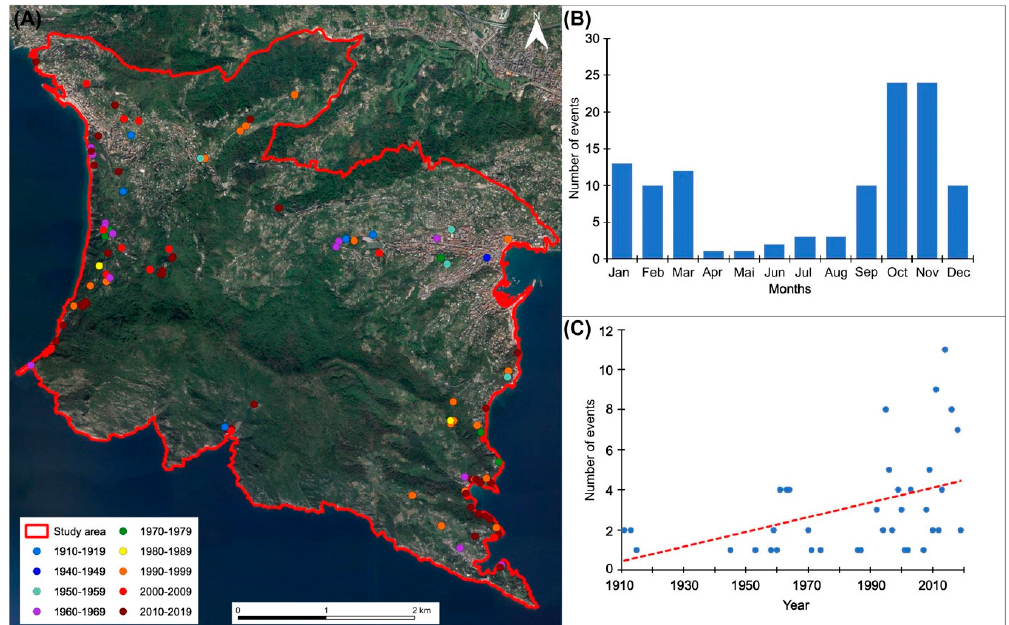
Figure 5. ( A ) Spatial distribution of the rainfall-induced shallow landslides and mud-debris flows that affected the Portofino promontory over the 1910–2019 period. ( B ) Monthly distribution of slope instabilities triggered by precipitations over the 1910–2019 period. ( C ) Distribution of annual landslide occurrences over the 1910–2019 period. occurrences over the 1910–2019